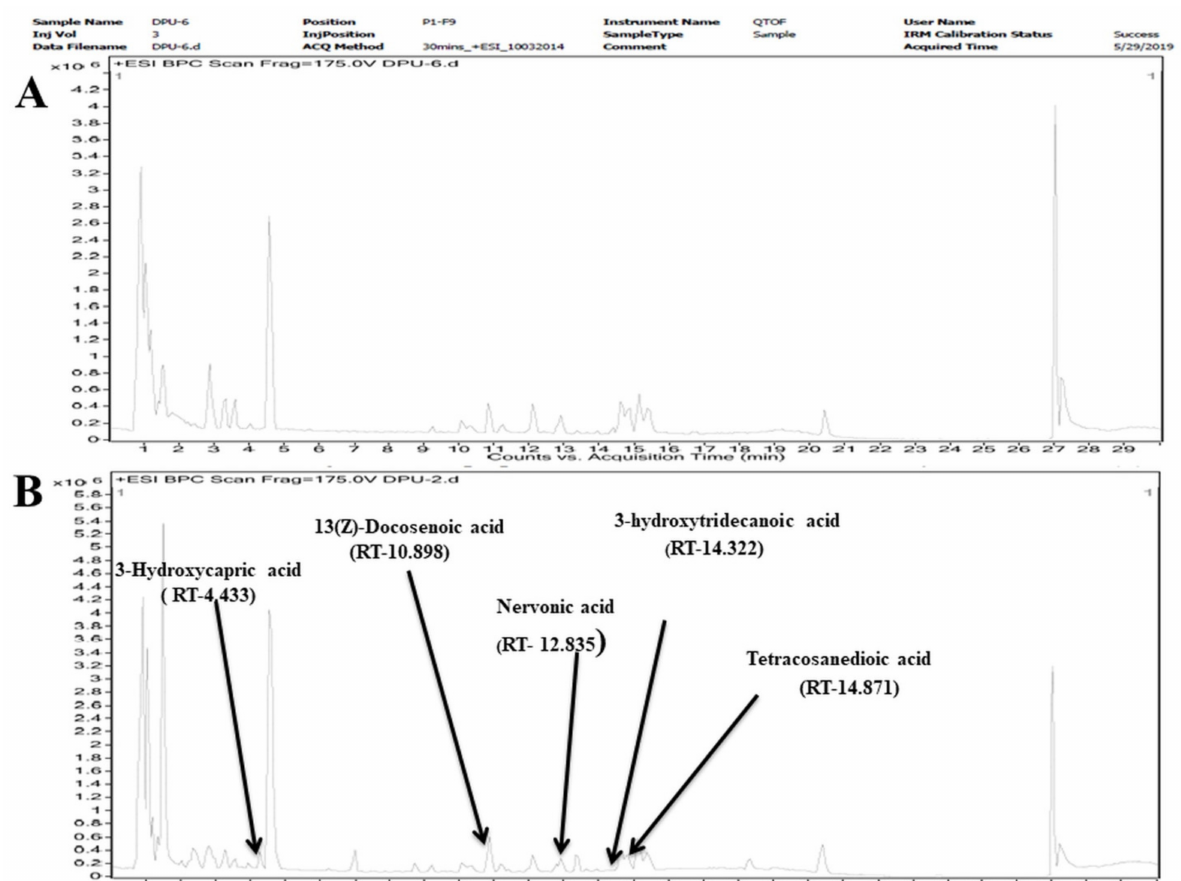
Figure 6. LC-HRMS total ion chromatogram of intracellular metabolites in DMSO- and CUDF-treated MCF-7 cancer cells. ( A ) VTGE-purified elutes of the intracellular metabolite pool in DMSO-treated MCF-7 cells analyzed by LC-HRMS in positive ion mode. ( B ) VTGE-purified elutes of the intracellular metabolite pool of MCF-7 cells treated with CUDF (50 µ g/mL) for 72 h analyzed by LC-HRMS in positive ion mode. The detailed procedure is described in the Experimental Procedure section, including the VTGE methodology and the parameters of